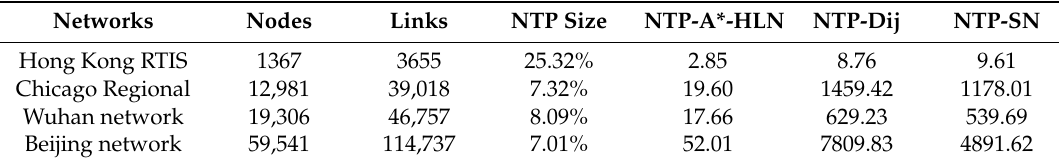
Table 2. Computational times of the three NTP construction algorithms in ms.